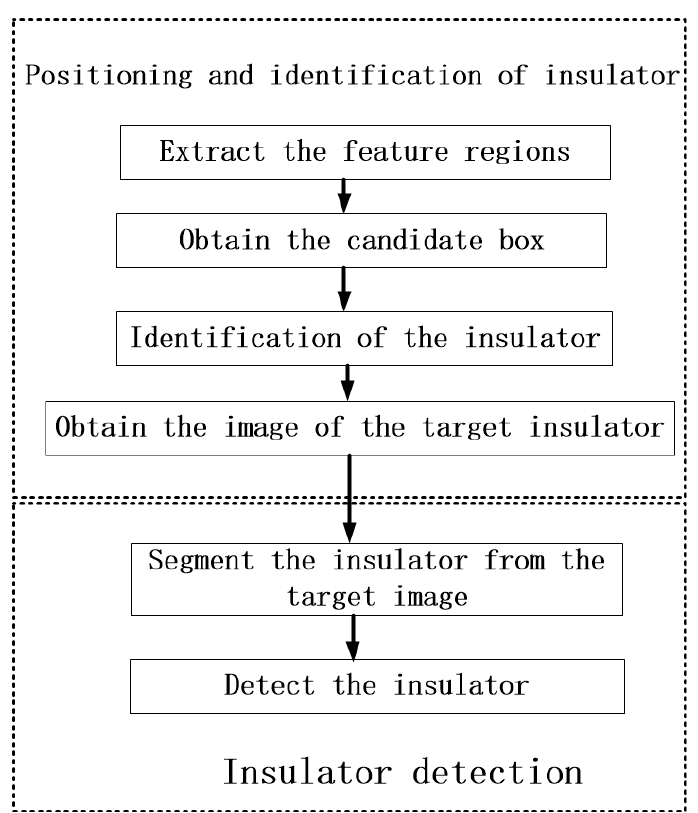
Figure 2. Insulator detection method.